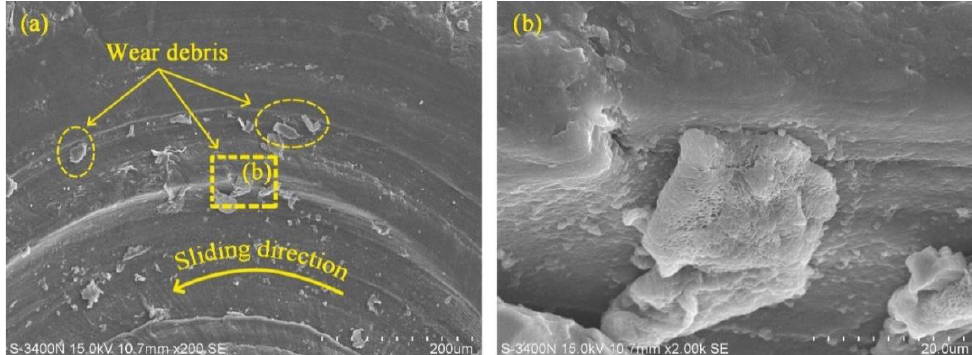
Figure 5. SEM micrographs of worn surface of UHMWPE under dry condition at 110 N applied load. ( b ) is the image taken at the marked position in ( a ).